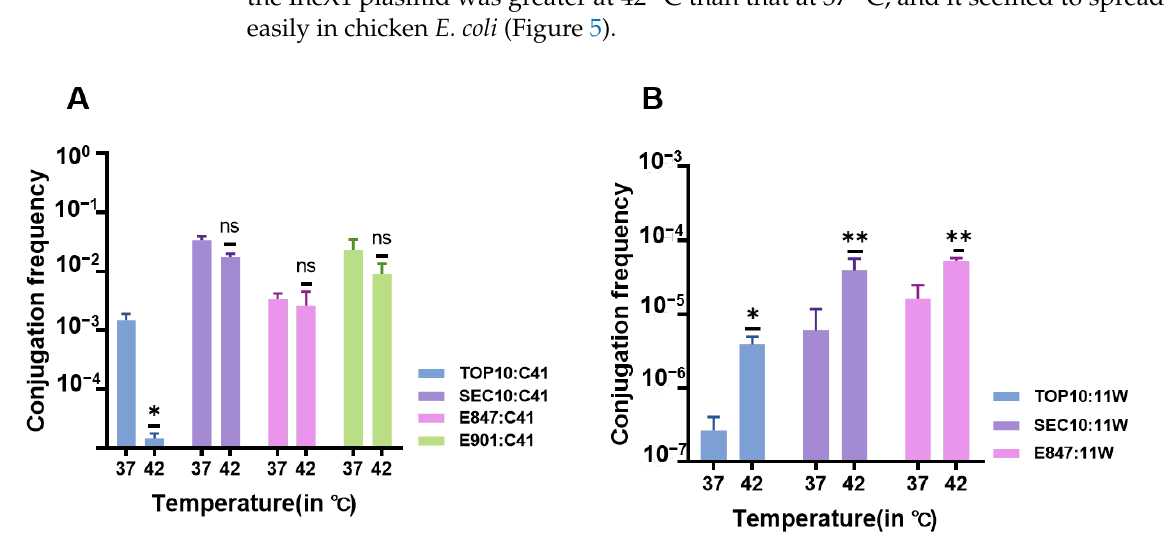
Figure 5. Conjugation frequencies of tet (X4)-bearing plasmids at 37 ◦ C and 42 ◦ C. ( A ): Conjugation